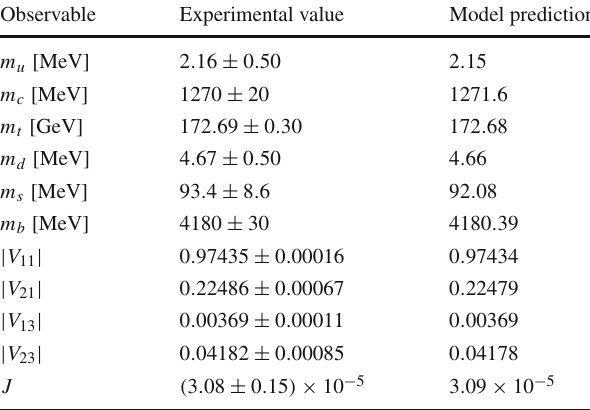
Table 2 Experimental values and fit